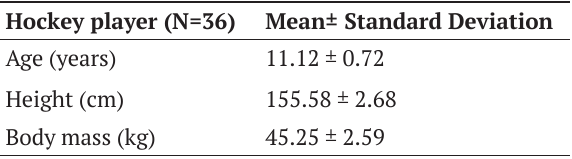
Table 1. Mean and standard deviation of participant physical